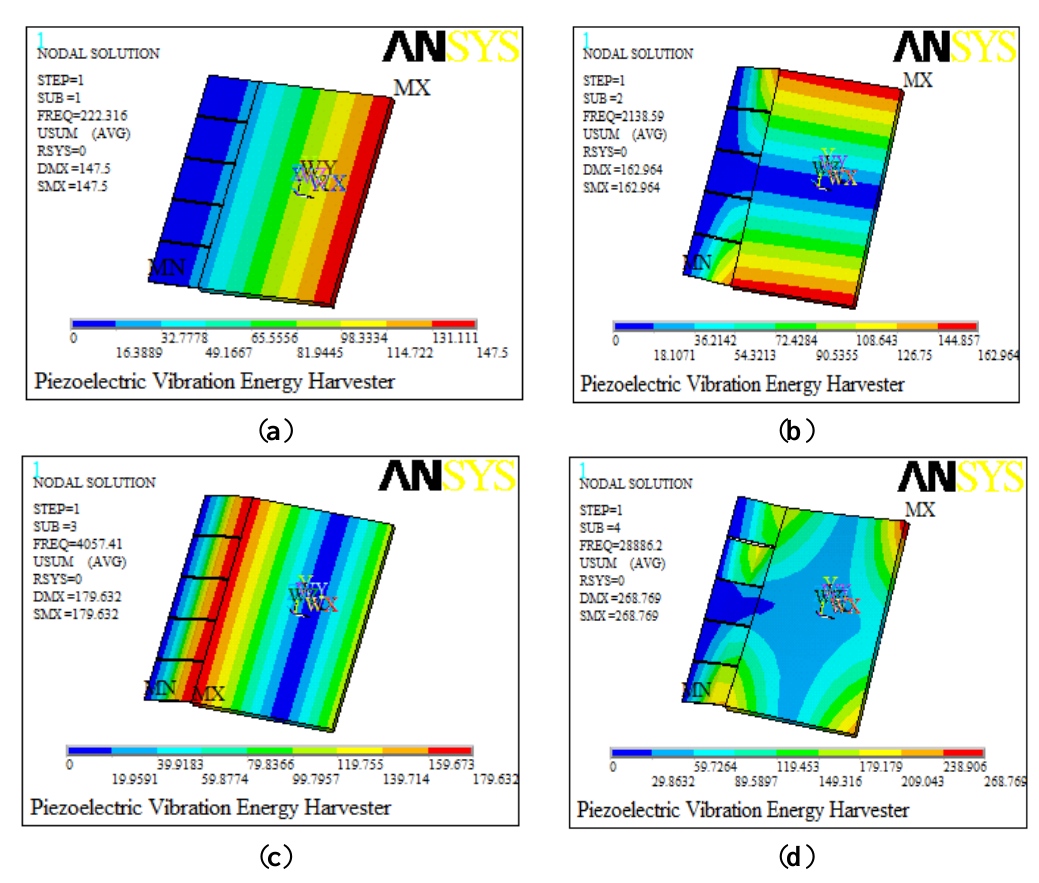
Figure 3. The first four resonant frequencies of the piezoelectric energy harvester. ( a ) The first resonant frequency. ( b ) The second frequency. ( c ) The third resonant frequency. ( d ) The fourth resonant